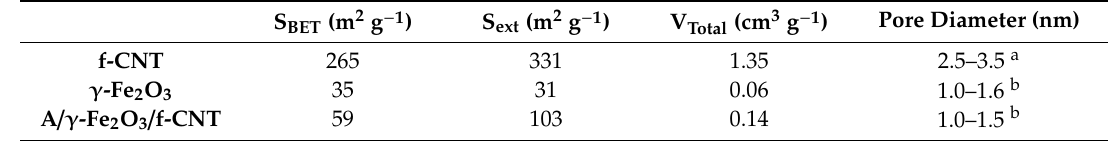
Table 1. Textural parameters of f-CNT, γ -Fe 2 O 3 and A / γ -Fe 2 O 3 / f-CNT beads.